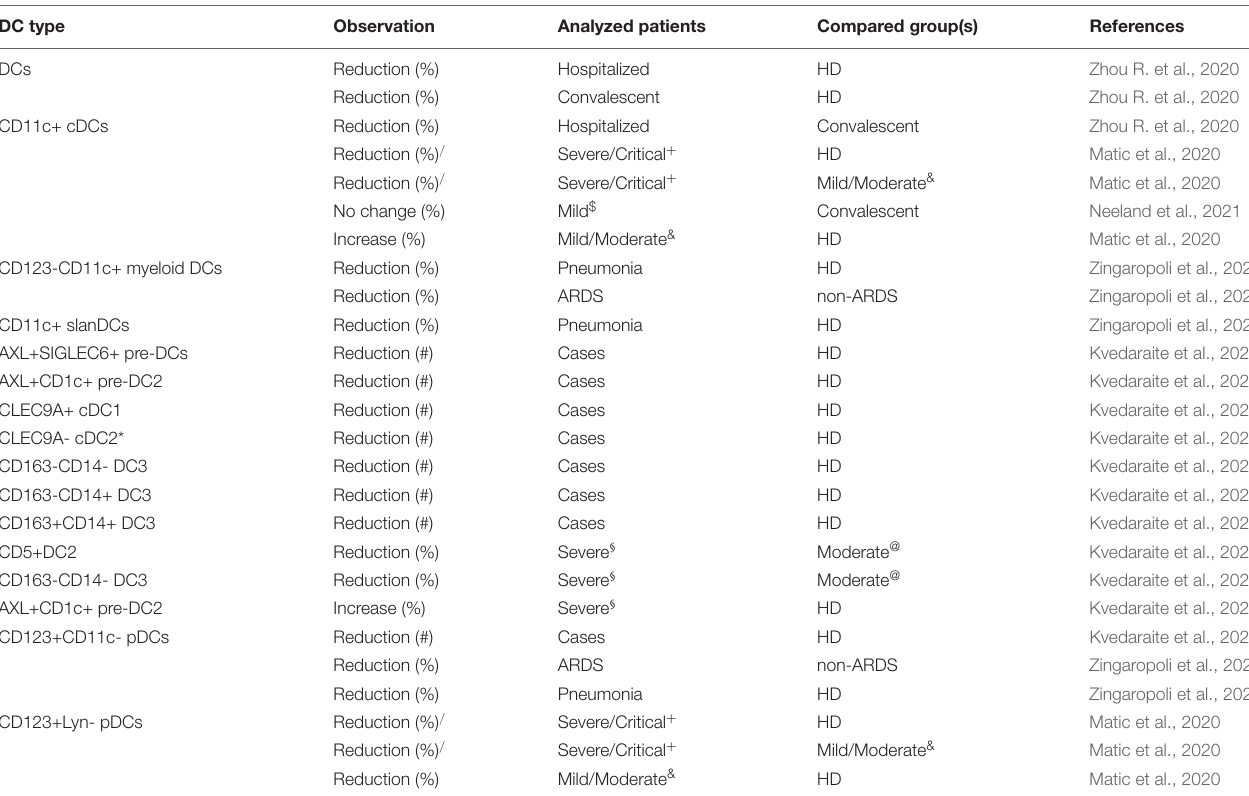
TABLE 2 | Observed fluctuation in DCs and DC subsets in adult COVID-19